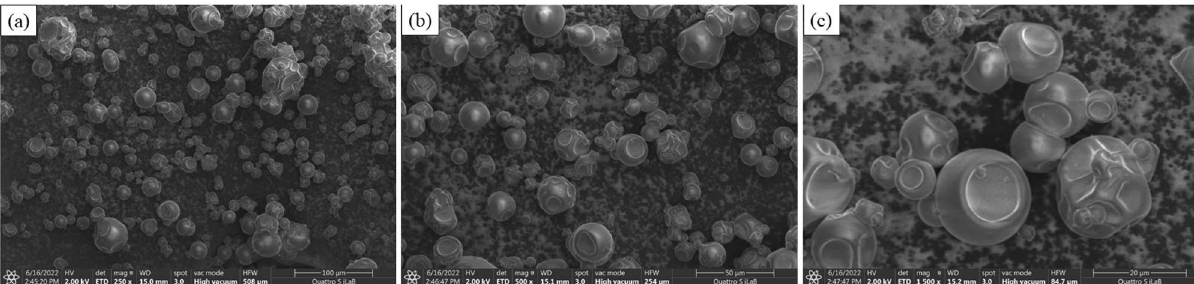
Figure 5. SEM images of microcapsules on 86.4 °C leaching temperature, 0.09 of leaves-water ratio and 10.72 min. Magnification: 250 × ( a ); 500 × ( b ); 1500 × ( c